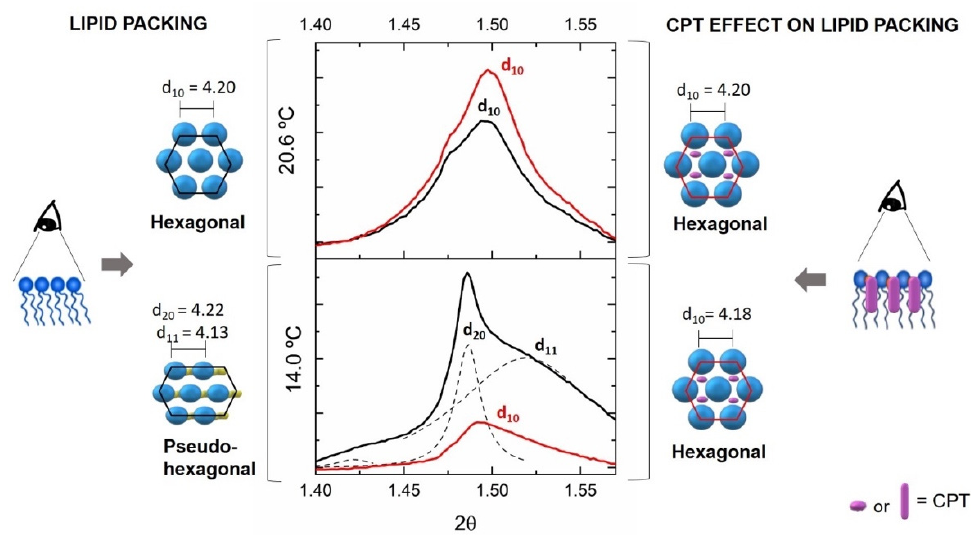
Figure 7. Wide angle X-ray diffraction (WAXS) patterns of DMPC (black) or DMPC containing CPT (red) measured in the L β′ (14.0 °C) and P β (20.6 °C) phases of DMPC. Solid lines give the best fit of the Lorentzian’s analysis model (dashed lines) to the scattered intensities. A model of drug–membrane interaction is proposed for each diffractogram together with the resultant d s values.